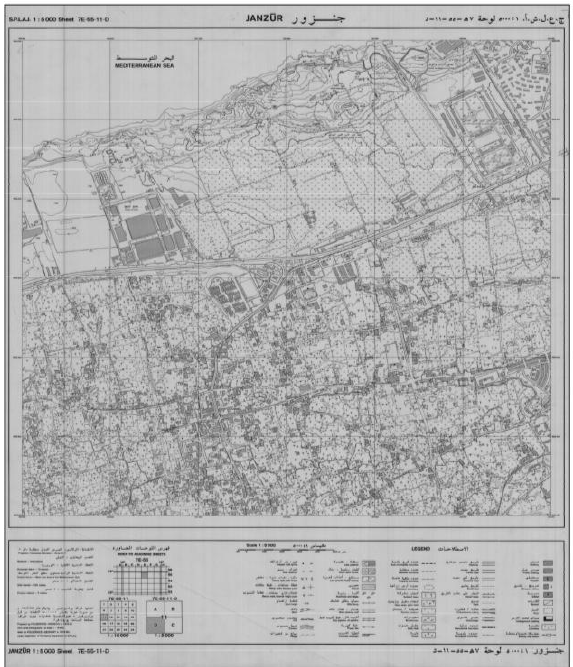
Figure 3. Analogue map sheet of Tripoli, Libya